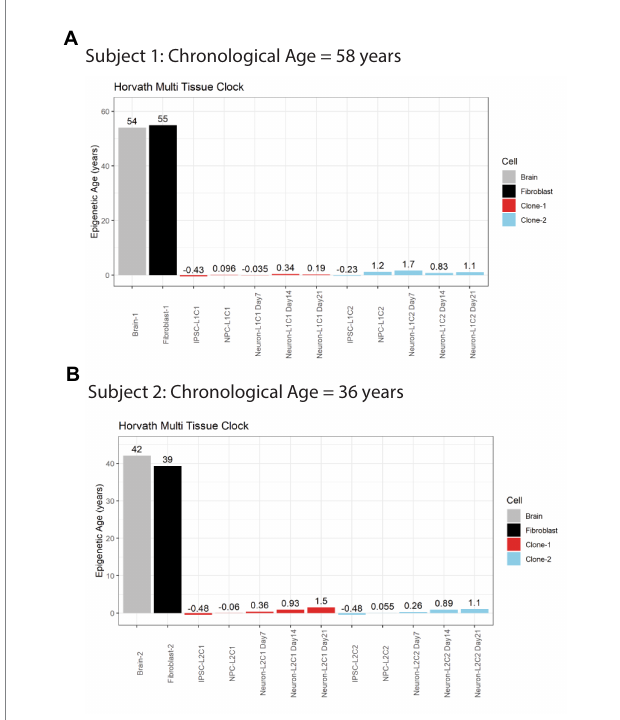
FIGURE 2 Horvath Adult epigenetic age of human brain vs.